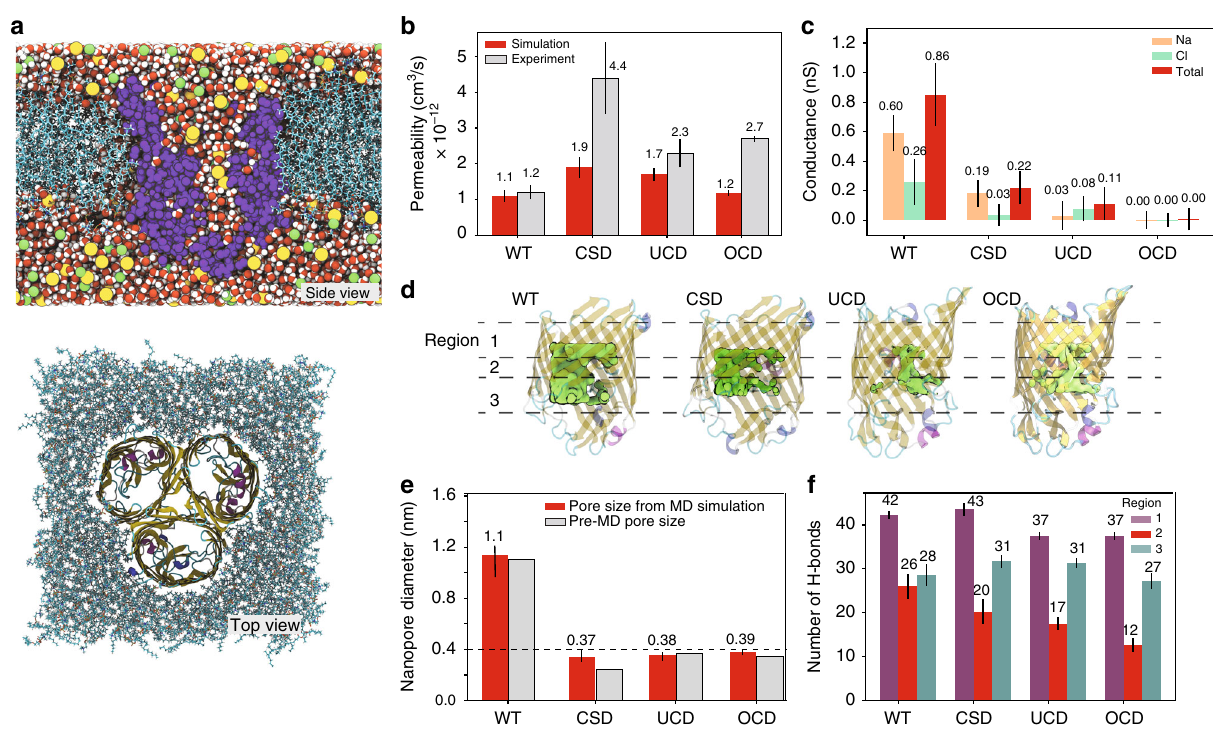
Fig. 5 MD simulations of OmpF corroborate experimentally observed permeability and selectivity trends. a Typical simulation system. (Top) Cut-away view of the system revealing a transmembrane water passage through an OmpF monomer. The OmpF monomer is depicted in purple, the lipid-bilayer in cyan, water molecules as red and white spheres, and Na + and Cl – ions as orange and green spheres, receptively. (Bottom) Top-down view of the system. The OmpF trimer is drawn using a cartoon representation, the lipid-bilayer as cyan bonds; water and ions are not shown. b Simulated osmotic permeability (averaged over 12,500 frames) of OmpF variants (red) and the corresponding experimental values (gray). c Ionic conductance of OmpF trimers obtained from applied fi eld simulations under a 500 mV transmembrane voltage and averaged over 10,417 frames. d Water occupancy of OmpF variants. The green volume depicts the average location of water molecules in each channel characterized as a 0.3 g/cm 3 isosurface of water oxygen density. For reference, each channel is shown using a semitransparent cartoon representation. e Major axis dimensions of the pores measured from PoreDesigner before MD (gray) and from the last 100 frames of MD (red). The error bars represent standard deviations. A 0.4 nm line represents the PoreDesigner design constraint of identifying pore designs smaller than 0.4 nm. f The average number of hydrogen bonds made between water and an OmpF monomer in each of the regions depicted in panel d and averaged over 14,583